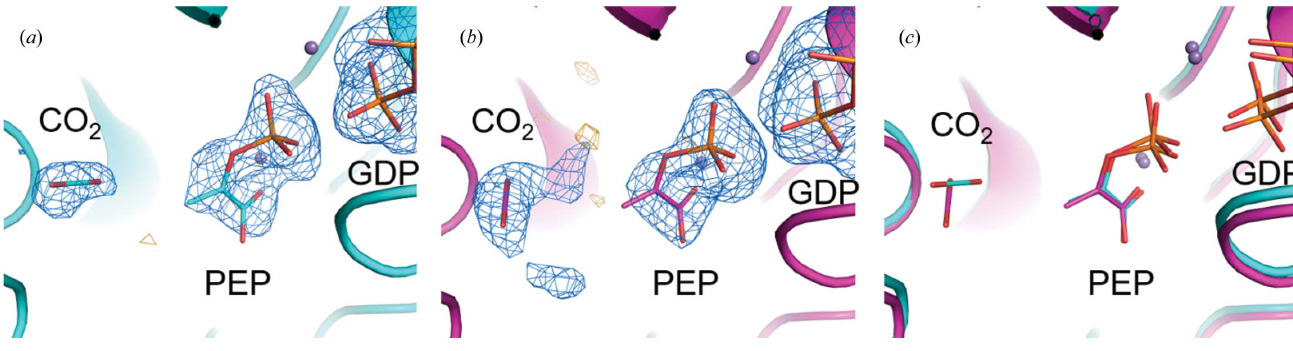
Figure 5 Comparison of CO 2 -binding sites at 40 and 120 ms and with a previous PEP-containing PEPCK structure. ( a ) Polder map at 4.5 r.m.s.d. of the CO 2 - binding site from the 40 ms MMQX data. ( b ) Polder map at 4.5 r.m.s.d. of the CO 2 -binding site from the 120 ms MMQX data. ( c ) Comparison of the CO 2 -binding sites at these two time points